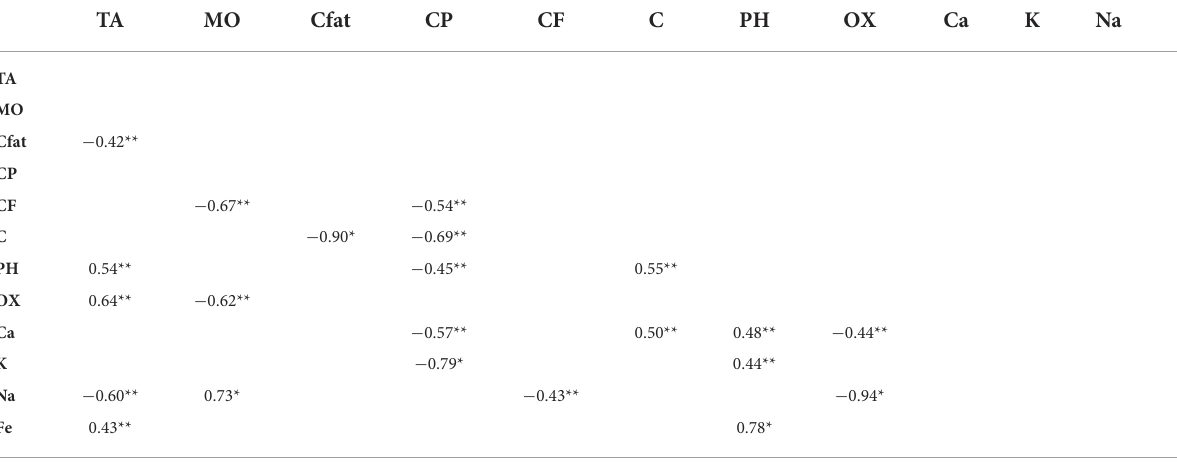
− 0.57** 0.50** 0.48** − 0.44** − 0.79* 0.44** − 0.60** 0.73* − 0.43** − 0.94* Fe 0.43**